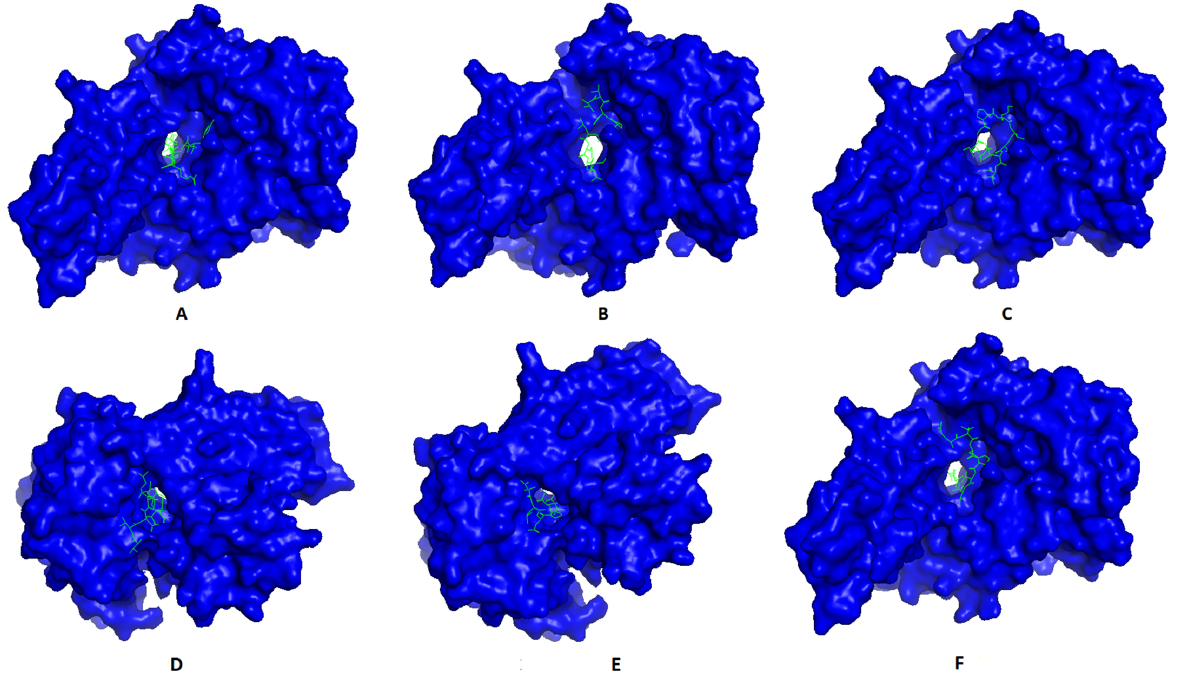
Figure 2. Structural positions of MHC-I epitopes (green color) in three-dimensional structure of HLA-A*11:01 (blue color); structures A, B, C, D, E , and F are for epitopes numbers 1, 2, 3, 4, 5, and 6, respectively, from Table 7.